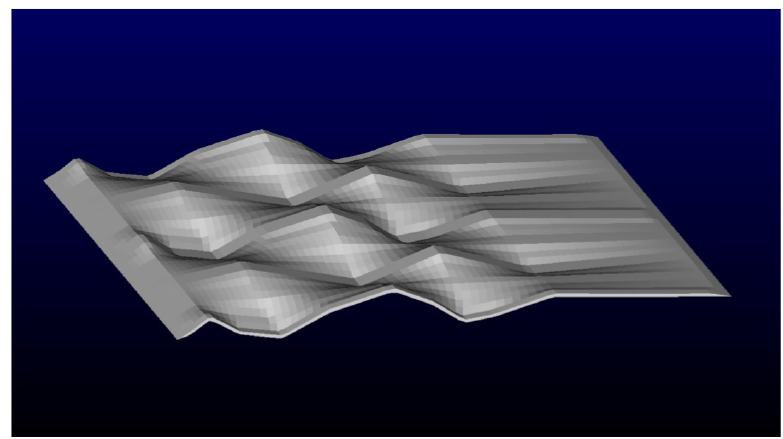
Figure 18. A three-dimensional corrugated wing shape.